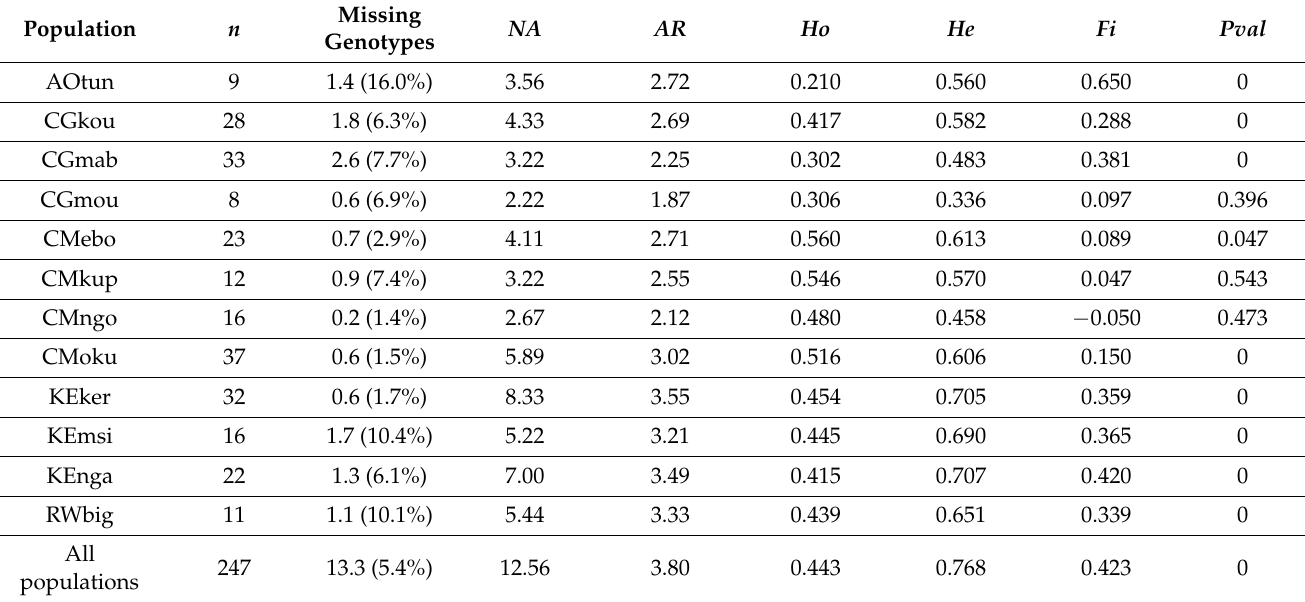
Table 1. Genetic diversity parameters of the 12 P. latifolius populations studied using nine nuclear SSR